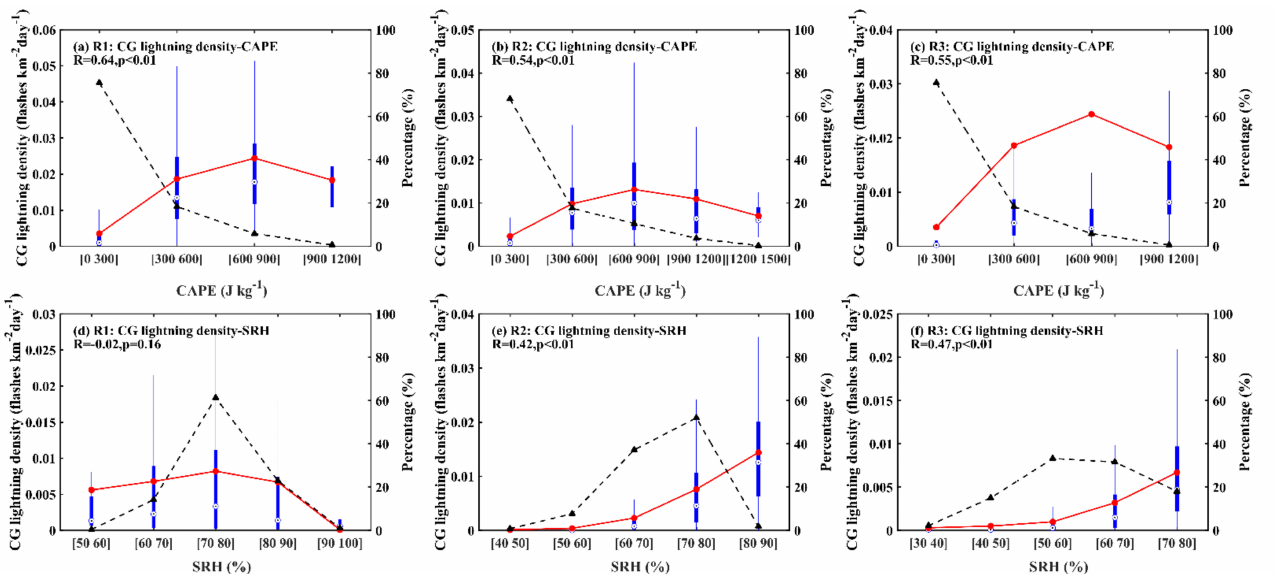
Figure 6. Box plots of CG lightning density (unit: flashes km − 2 day − 1 ) dispersion showing the relationship between the CG lightning density and two thermodynamic factors (derived from ERA5): ( a )~( c ) CAPE and ( d )~( f ) SRH over the three study regions during 2010–2018. Box plots represent the 25th to 75th percentile of the data in this box (the distance between the bottom and the top of the box), the median (the white circle in each box), the maximum (the end of the whisker above), and the minimum (the end of the whisker below). The red dot in each box represents the mean. The black dot represents the percentage of data points in each bin of CAPE or SRH to the total data point. The Pearson correlation coefficients (R) and p values are also presented in each panel. Data from all seasons are included.